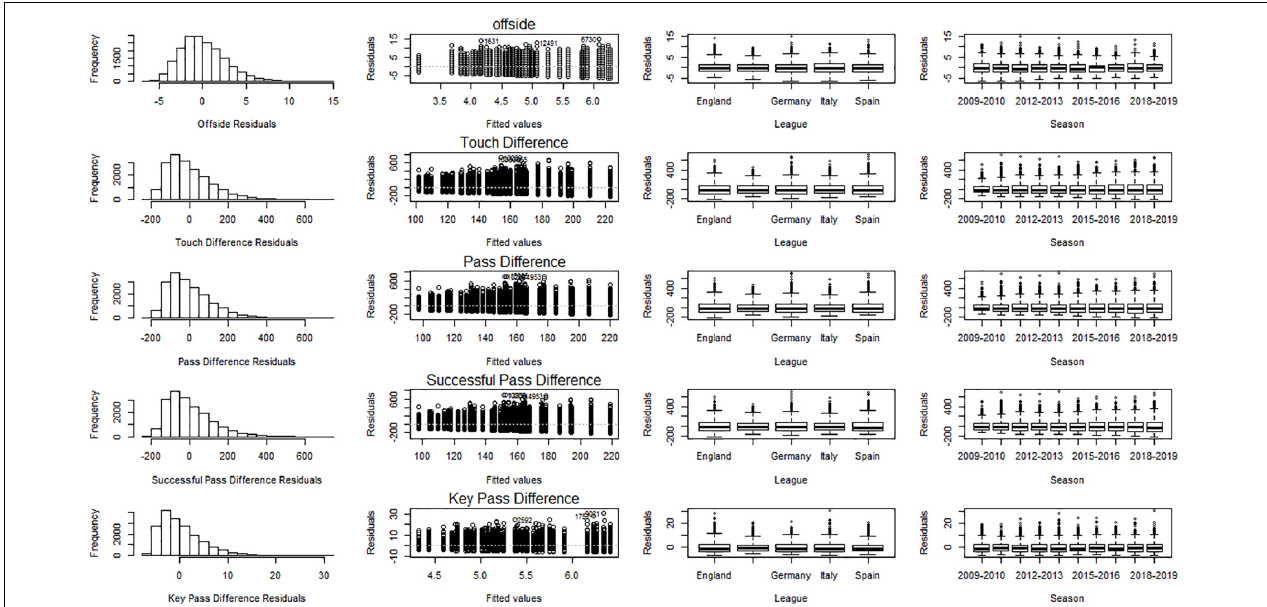
FIGURE 1 | Model validation graphs. Histogram of the residuals (normality). Fitted values versus residuals (independence). Residuals versus league (homogeneity). Residuals versus season